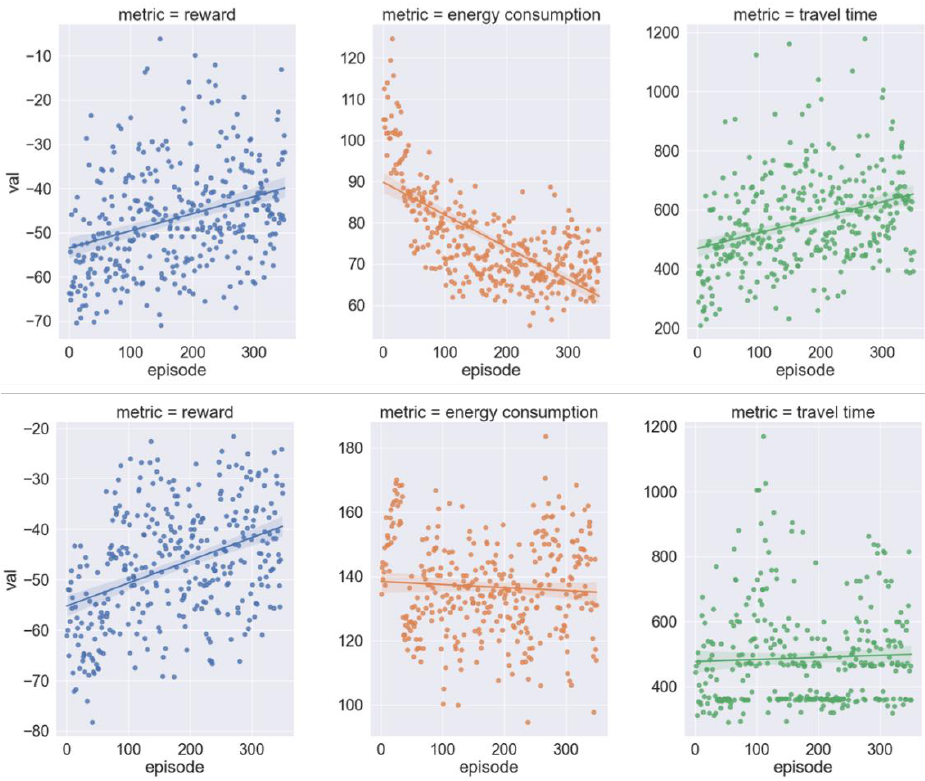
Figure 7. The change of reward, energy consumption, and travel time during the training processes of PPO and RAINBOW. of PPO and